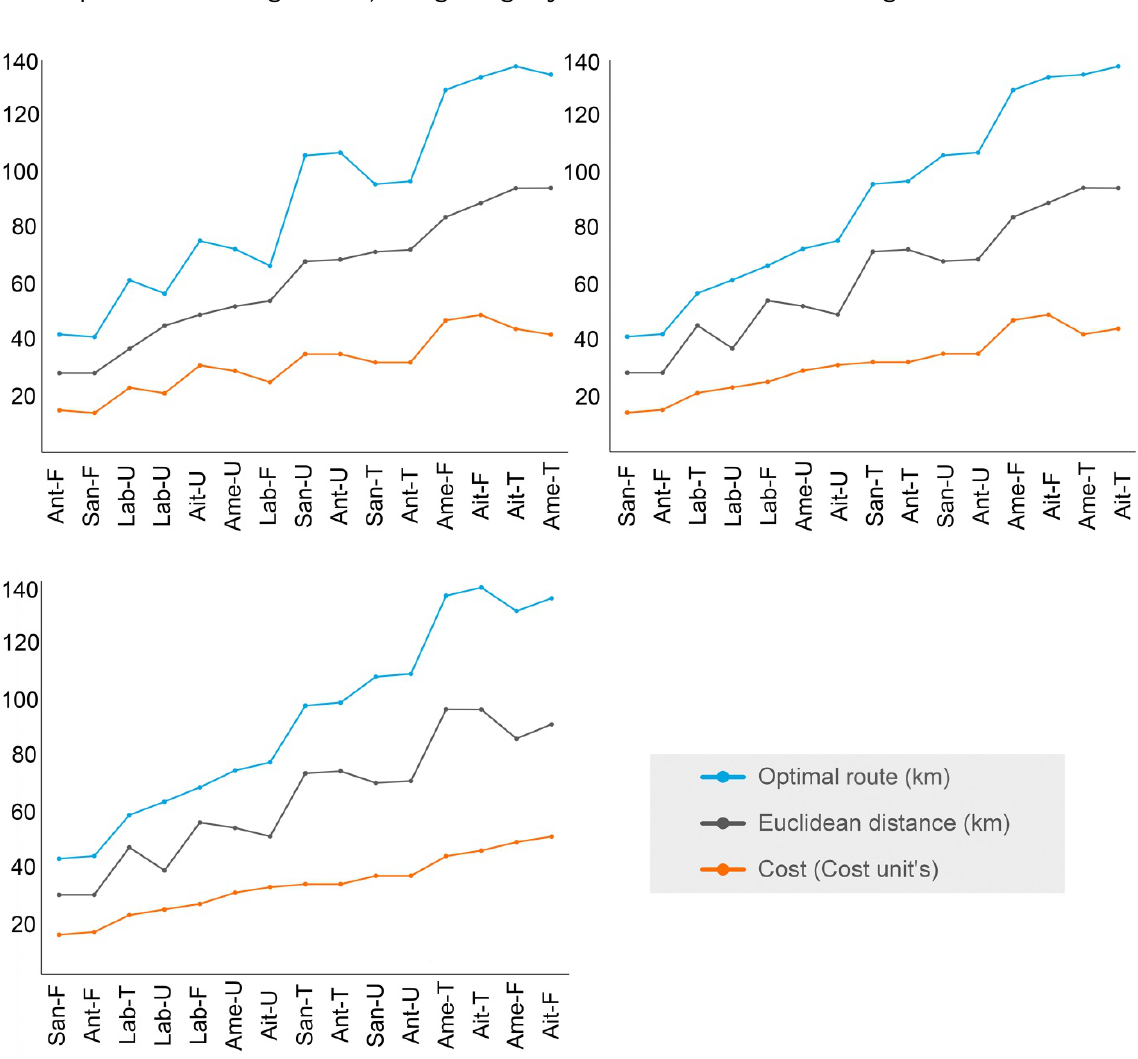
Figure 11. Triple graphic showing, on the horizontal axis, all the possible routes between archaeological sites and geological outcrops, ordered incrementally according to the three types of measurement used. The first one is ordered based on Euclidian distance, the second based on optimal route and the third is based on cost. The vertical axis represents two types of units of measurement contemporaneously on the same scale: kilometres, for Euclidian distance and optimal route, and CU, for cost. Variations in the order of the routes and the curves generated are